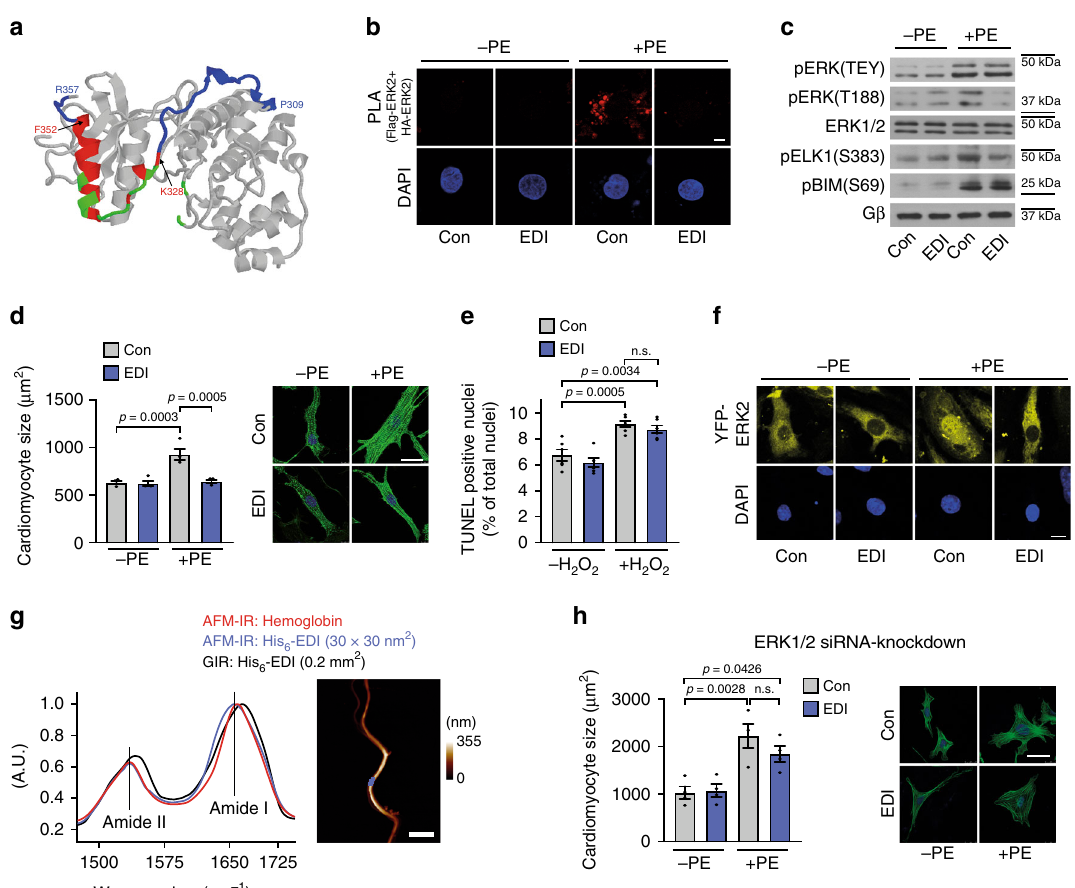
Fig. 3 EDI-based interference with ERK dimerization. a Proposed ERK dimer interface 26 in crystalized ERK2 (pdb ID: 2ERK). Peptide JOLU22 (ERK 328 – 352; red) presents nine of the 11 residues involved in dimer interactions (green). EDI (ERK 309 – 357) is marked in blue. b Proximity ligation assay (PLA) in NRCM transduced with HA- and Flag-tagged ERK2-wt and control virus (LacZ; Con) or myc-ERK2 309 – 357 (EDI) in response to PE (4 µ M, 10 min; n = 4; 15 – 20 cells per group and experiment; scale bar 5 µ m). Proximity-ligated HA- and Flag-tagged ERK are indicated in red, DAPI-stained nuclei in blue. c – f NRCM transduced with LacZ (Con) or EDI. c Representative western blots of nuclear (pELK[S383], n = 8) and cytosolic (pBIM[S69], n = 13) ERK1/2 target phosphorylation and of ERK(TEY)- and ERK(T188)-phosphorylation (pERK[TEY], n = 8; pERK[T188], n = 8) in response to PE (4 µ M, 10 min). Quanti fi cations: Supplementary Fig. 6B. d Representative phalloidin-stainings and quanti fi cation of cell size in response to PE (4 µ M, 24 h; n = 4; 40 cells and experiment; scale bar 20 µ m). e TUNEL-positive NRCM; H 2 O 2 stimulation (100 µ M, 1 h; n = 6 independent experiments with 500 – 1000 cells per experiment and group). f Nucleocytosolic distribution of YFP-tagged ERK2-wt (yellow) in the absence and presence of EDI and PE (4 µ M, 10 min). DAPI- stained nuclei (blue). Scale bar 10 µ m. Quanti fi cations: Supplementary Fig. 4A. g Atomic force microscopy-infrared (AFM-IR) spectra of the puri fi ed His 6 - EDI (blue) and hemoglobin (red) aggregates. The Amide I band maximum at ~1656 cm − 1 indicates a dominant alpha-helical structure. Hemoglobin was used as a reference protein containing α -helices. Grazing angle IR (GIR) spectrum of an ~1.5-nm-thick His 6 -EDI (black), indicating a similar structure in fi lm and aggregates. The right panel shows an AFM-image of the His 6 -EDI aggregate (measured spot is marked blue, scale bar 3 µ m). h NRCM size analyzed after treatment with siERK1/2 and Con or EDI and PE (4 µ M, 24 h). Representative confocal pictures of phalloidin-stained cells and quanti fi cations ( n = 4; 64 – 80 cells per group; scale bar 20 µ m). Error bars are mean ± s.e.m.; ordinary one-way ANOVA and Bonferroni as post hoc test was applied; n numbers represent biologically independent experiments. Source data are provided as Source Data fi